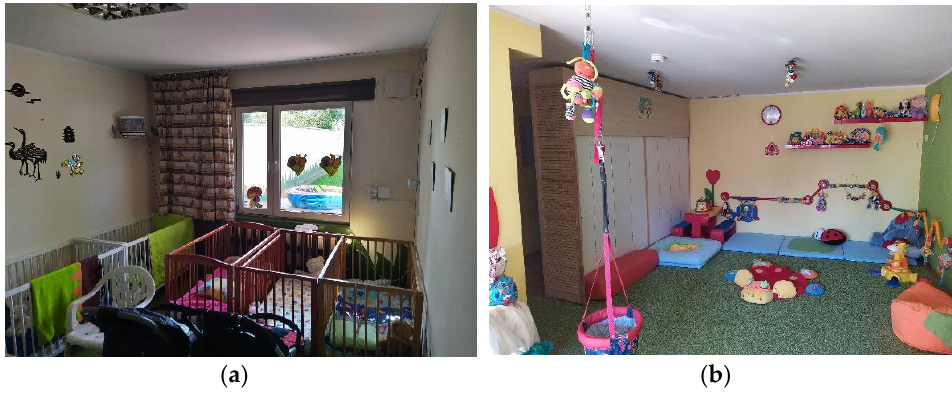
Figure 3. Rooms analysed: ( a ) Sleeping room; ( b ) Main room.